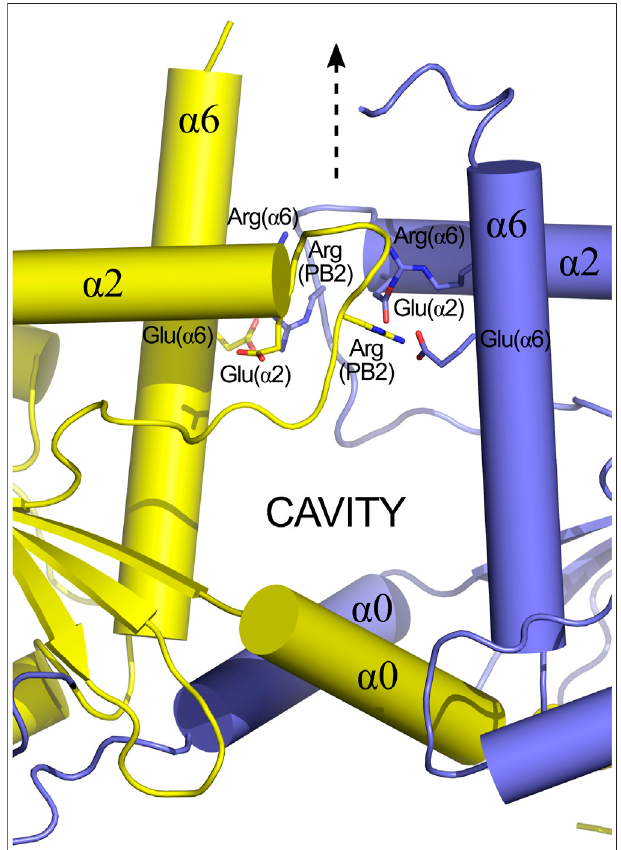
FIGURE 12 | The NC-interface and its cavity (PDB:7M6J, chains D and E). SEPT6 and SEPT7 are coloured in blue and yellow, respectively. The pseudo symmetry diad is displayed (dashed arrow). The NC-interface has an upper part (indicated by residues around the C-terminus of helices α 2) and the lower part ( α 0). In the upper part, four residues conserved in most septinsareindicatedonbothsubunits:Glu( α 2),Arg(PB2),Glu( α 6)andArg( α 6). The inter-subunit electrostatic interactions are made between Glu( α 2) and Arg(PB2), Glu( α 6) and Arg(PB2) and Arg( α 6) with the helical dipole of helix α 2.